Question: Based on the figure, does the quantity rise or fall?
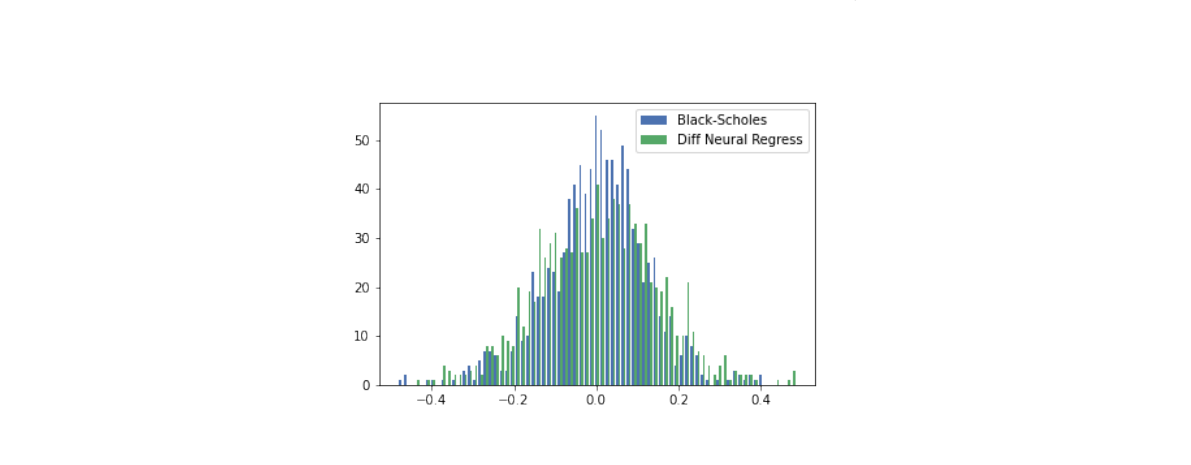
Answer: increasing